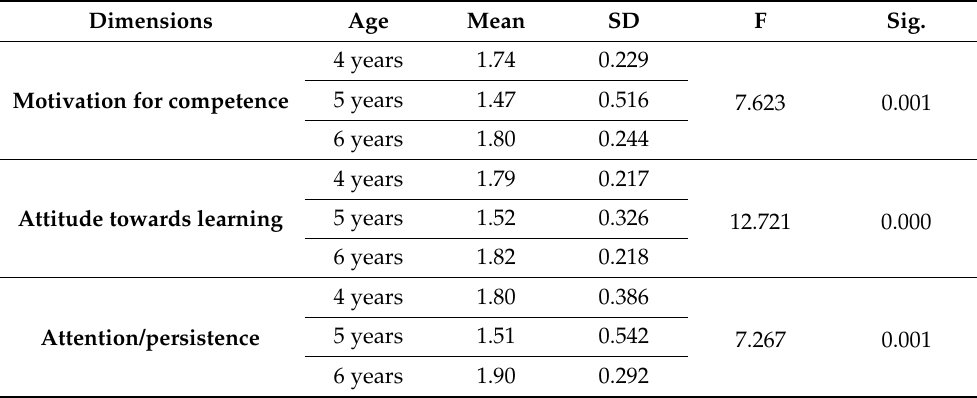
Table 4. ANOVA for learning and age of participants.